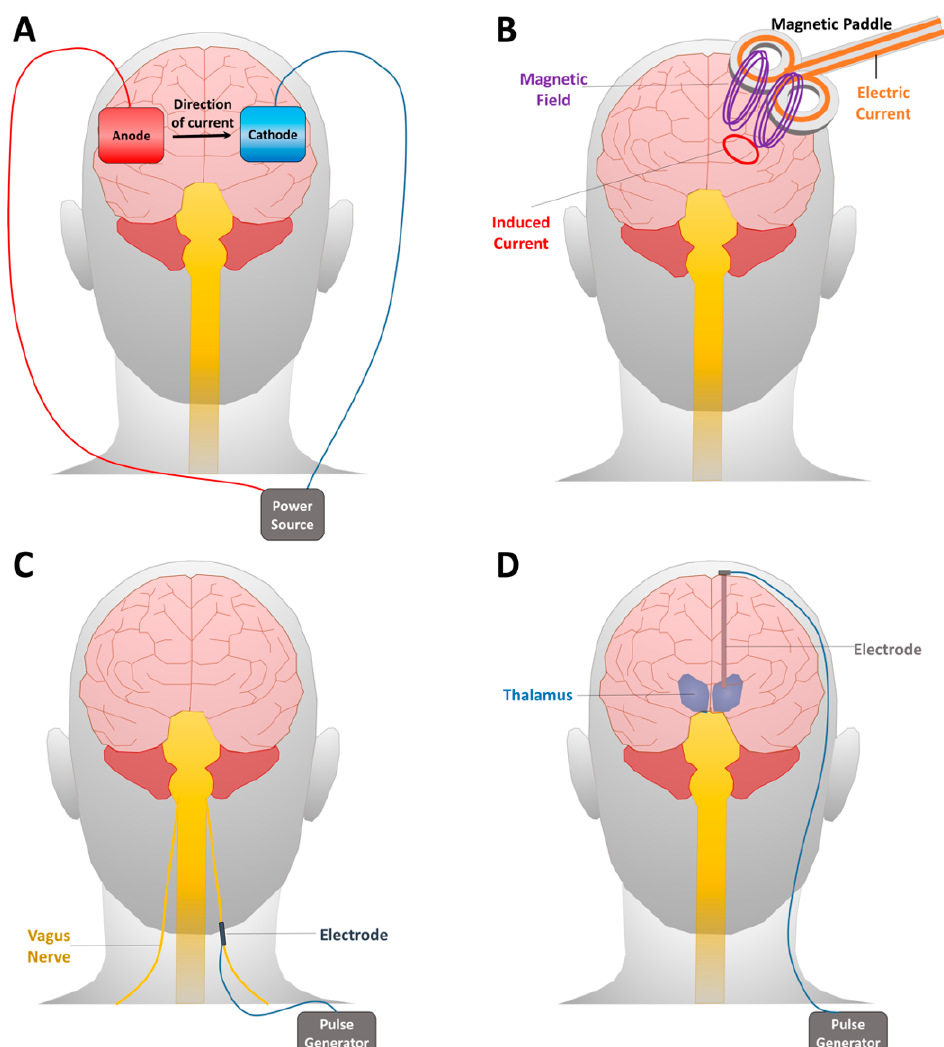
Figure 2 . Diagram of electroceuticals used in patients with severe DoCs. ( A ) tDCS utilizes two electrodes that are placed on the scalp (an anode and a cathode) that are connected via wires to a power supply. Together, this makes a complete circuit through which a constant, low (1–2 milli- ampere; mA), electrical current is delivered for a set amount of time. ( B ) rTMS utilizes the flow of electric current through a magnetic coil placed over the scalp, generating a rapidly changing magnetic field that induces an electrical current. ( C ) VNS employs a pulse generator implanted under the skin that is connected by a wire to an electrode that is on the left vagus nerve. ( D ) DBS employs a pulse generator implanted under the skin that is connected by a wire to an electrode generally implanted into the